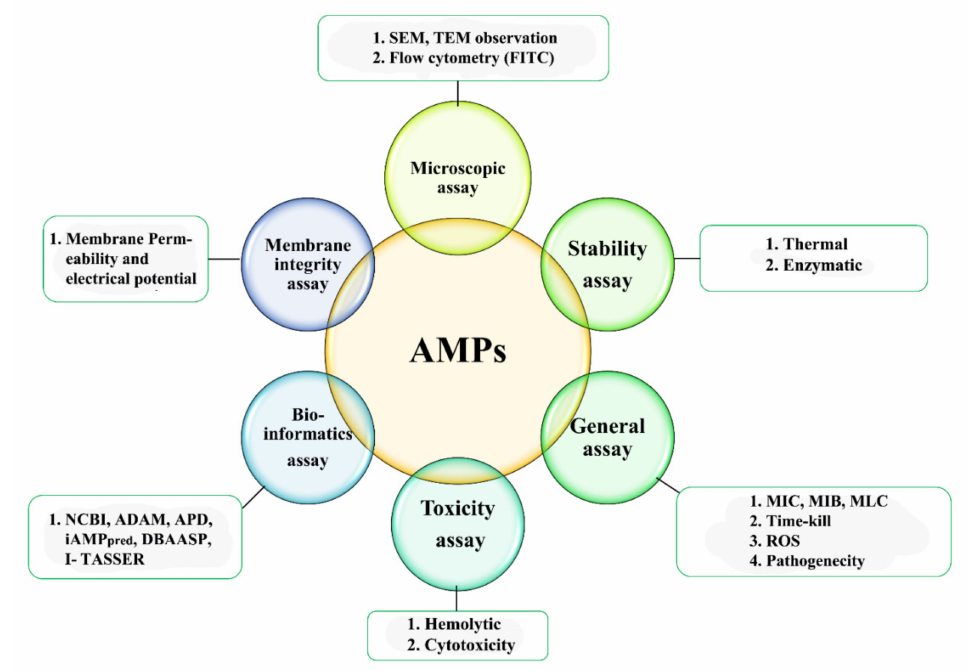
Figure 3. Different techniques for AMPs